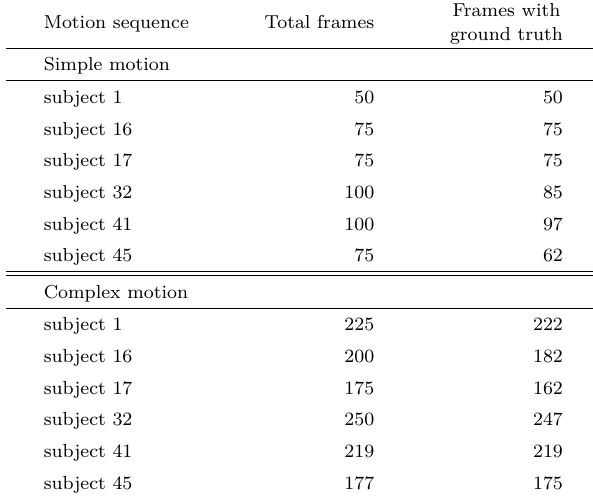
Table 2 Numbers of frames for every image sequence taken from the complete MoVi video of a subject. In some instances ground truth data were not available for frames from the beginning or end of a